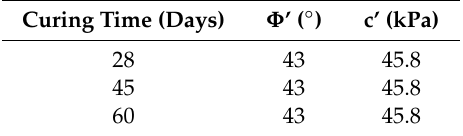
Figure 8. Results of rotational mixer test for products A, B, and C.